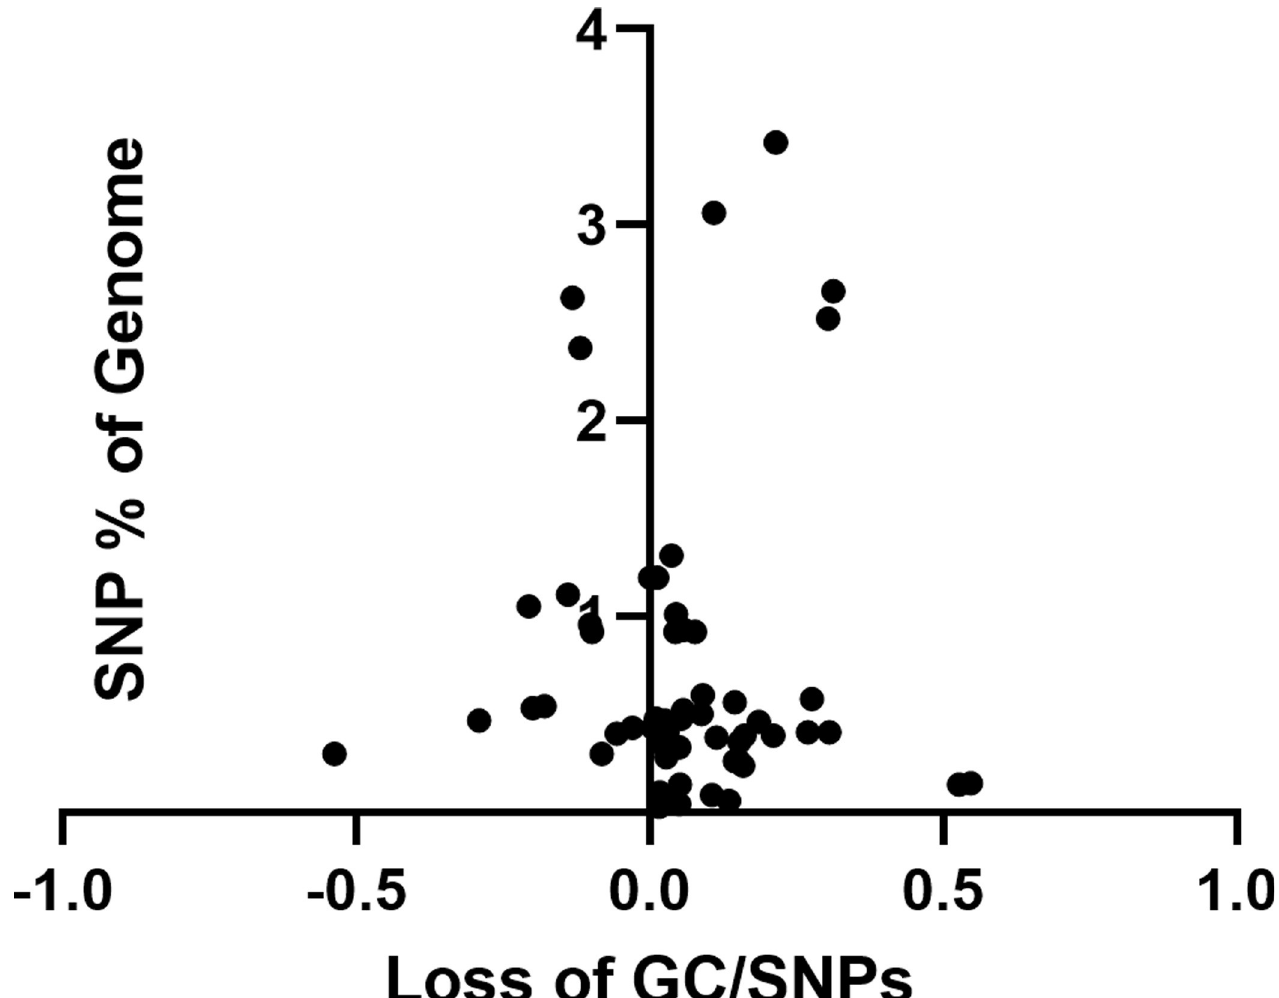
Fig 2. Change in genomic GC content (X axis) versus the number of SNPs analyzed relative to the size of the genome.